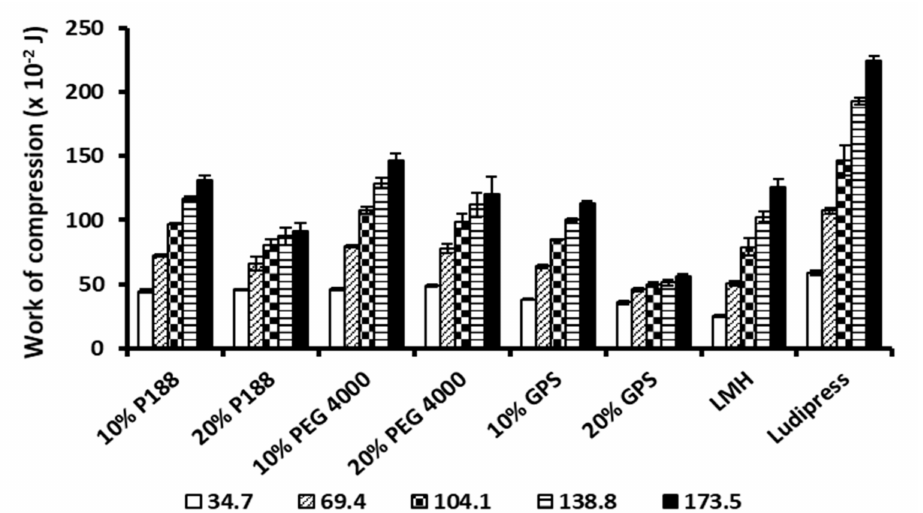
Figure 2. Calculated net work of compression for co-processed mixtures, LMH and Ludipress ® in the range of compression pressures 34.7–173.5